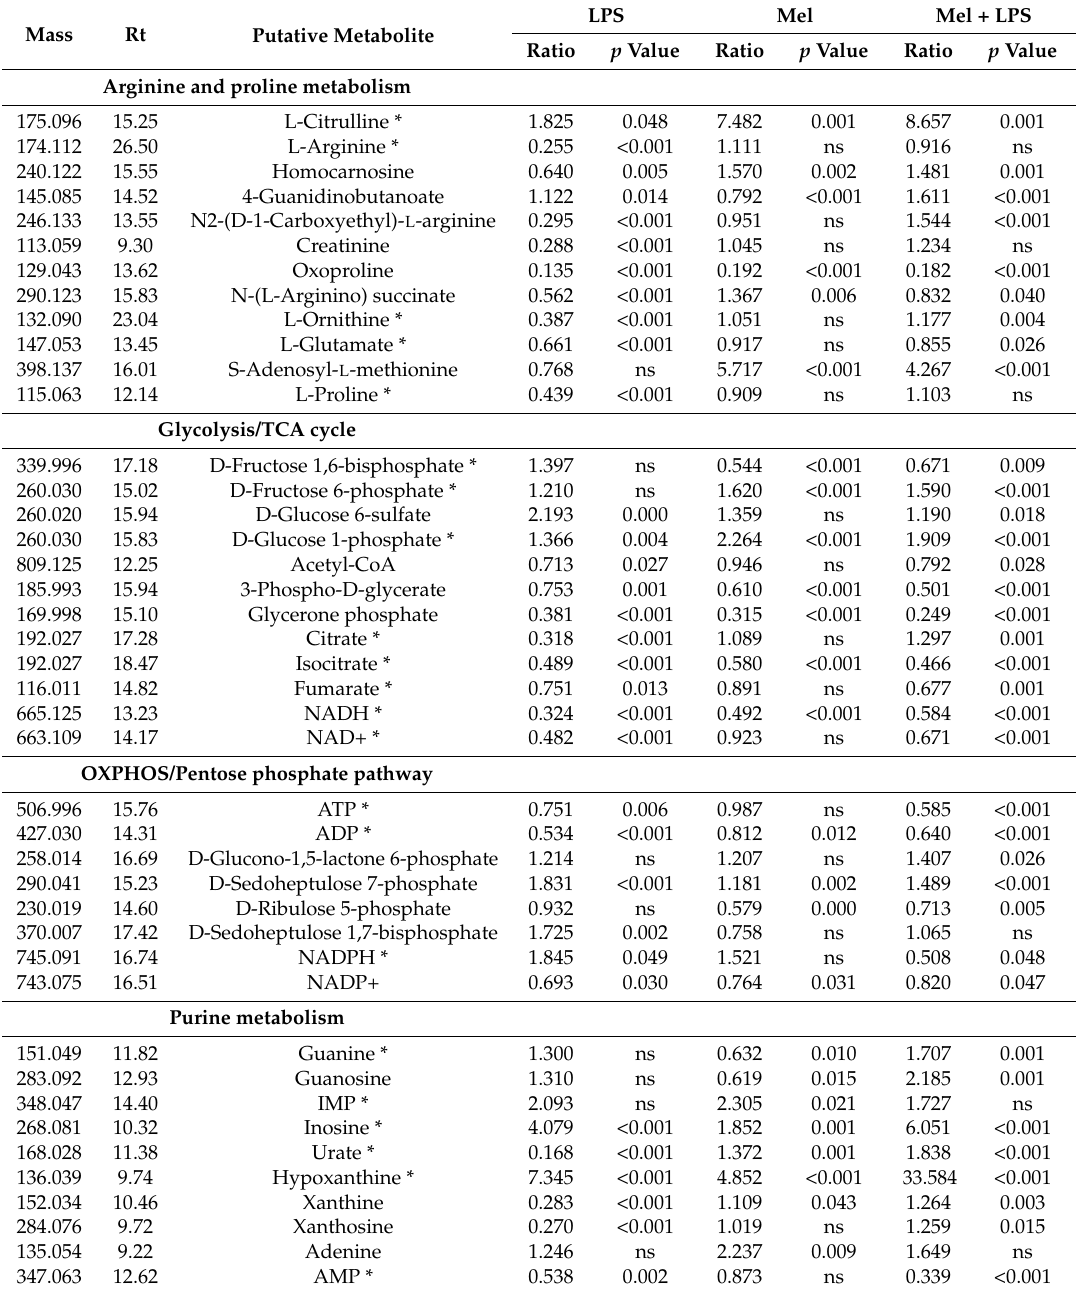
Table 1. Significantly changed metabolites within THP-1 cells treated with lipopolysaccharide (LPS), melittin, and melittin + LPS in comparison with untreated controls. The results contain the majority